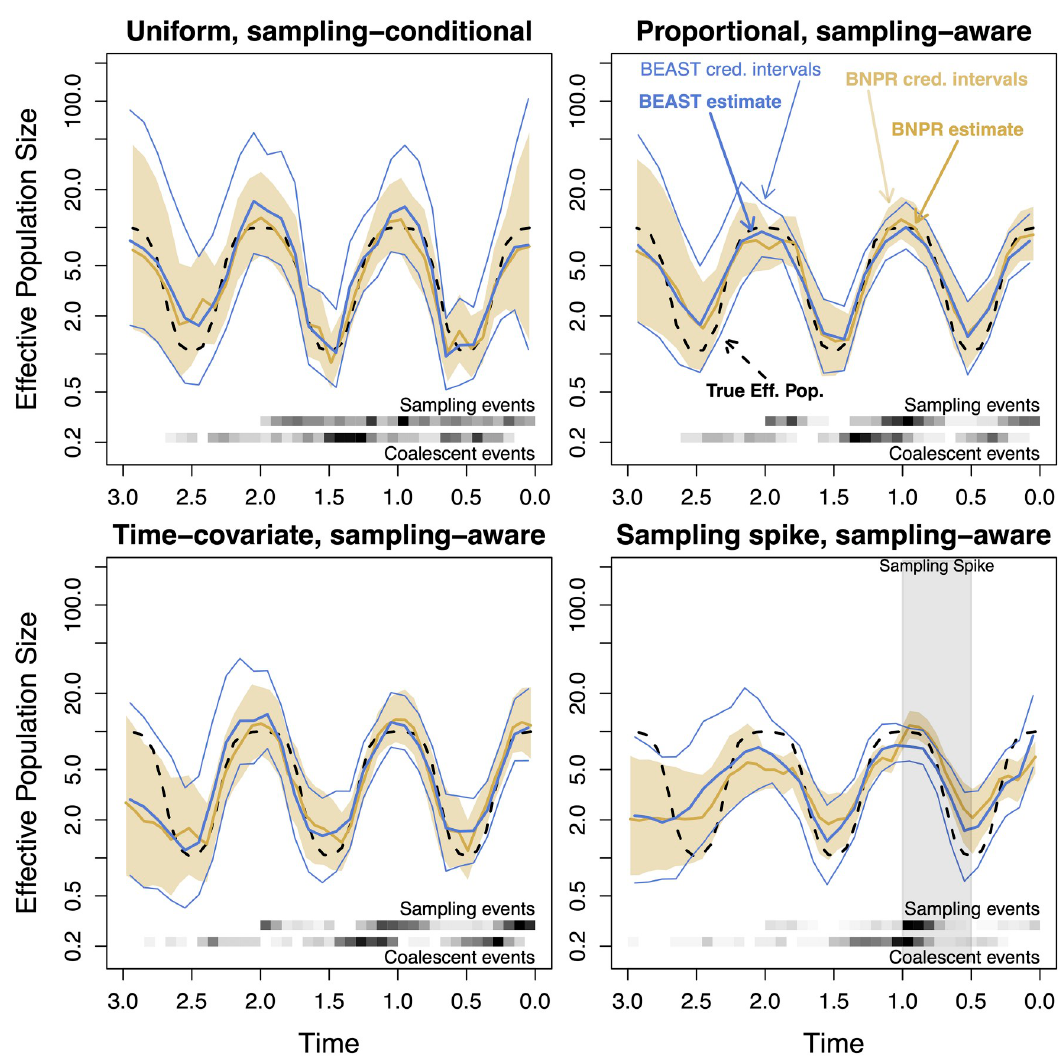
Fig 4. Effective population size reconstructions for four sequence data simulations, all based on the same seasonal effective population size trajectory. Upper left : Uniform sampling times, sampling-conditional posterior. Upper right : Sampling frequency proportional to effective population size, sampling-aware posterior. Lower left : Sampling frequency proportional to effective population times a time-covariate (exp( t )), sampling- and covariate-aware posterior. Lower right : Sampling frequency proportional to effective population size with a sampling spike, sampling- and covariate-aware